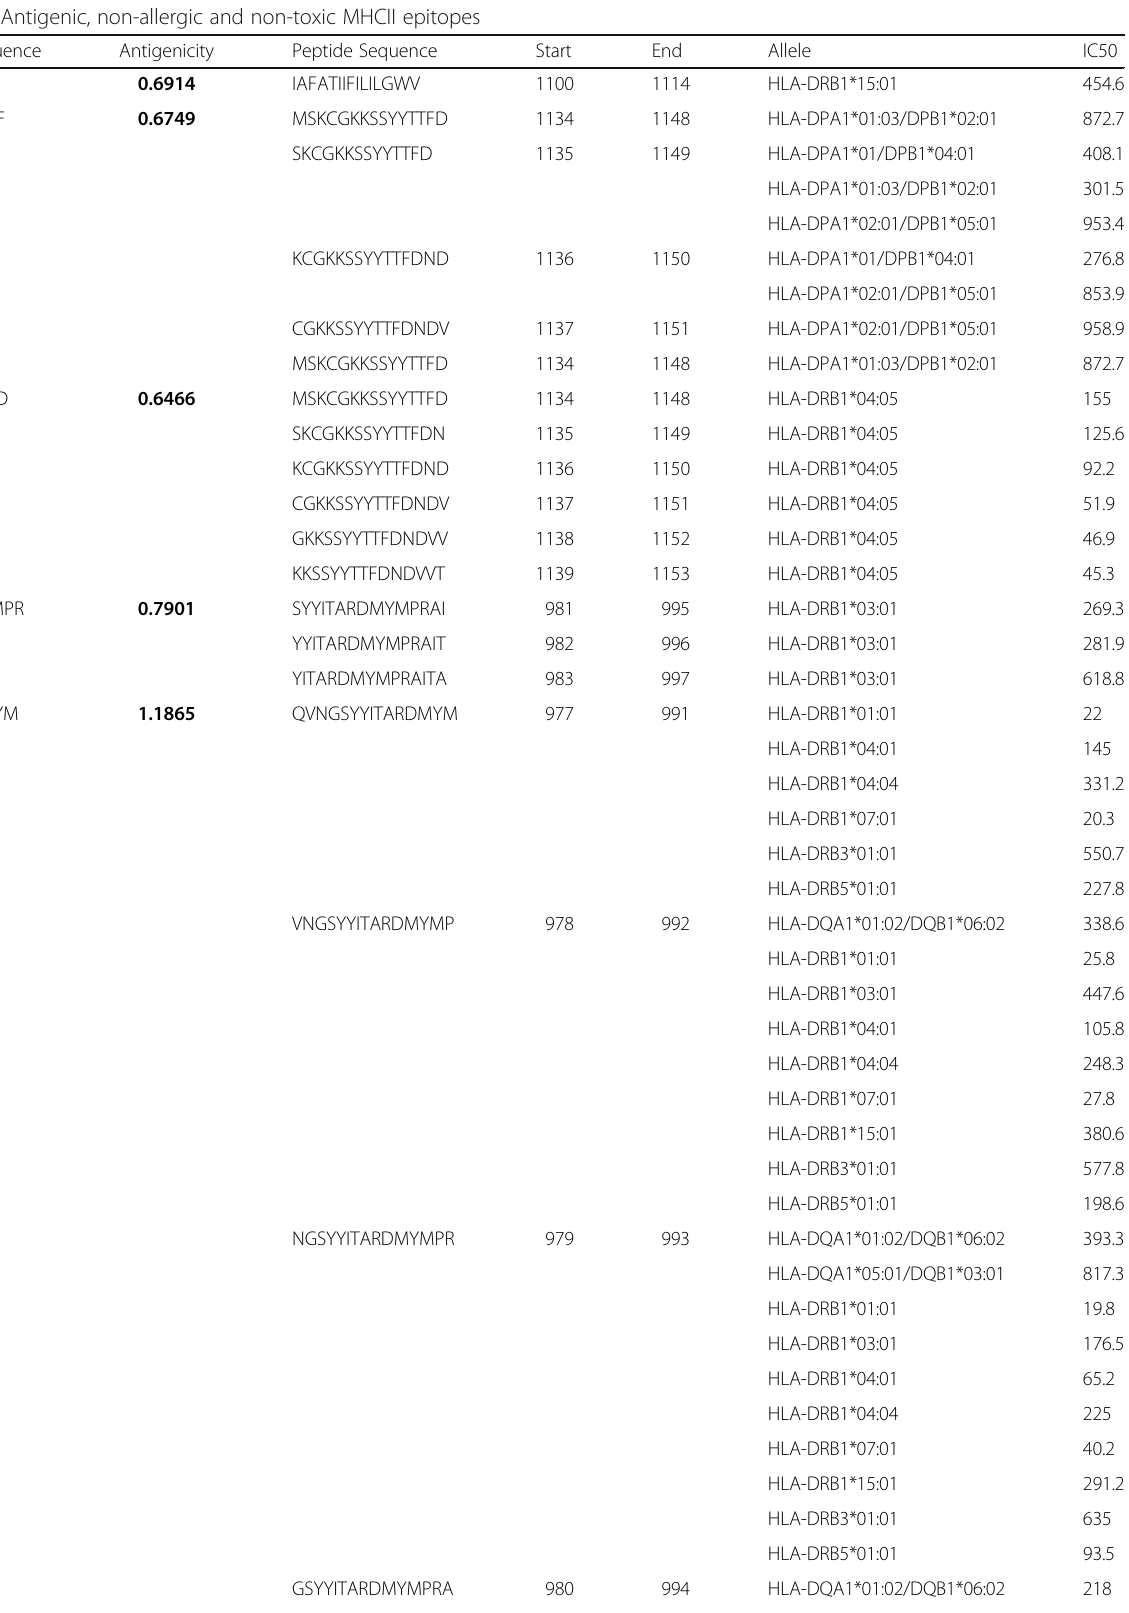
Table 7 Antigenic, non-allergic and non-toxic MHCII epitopes Core